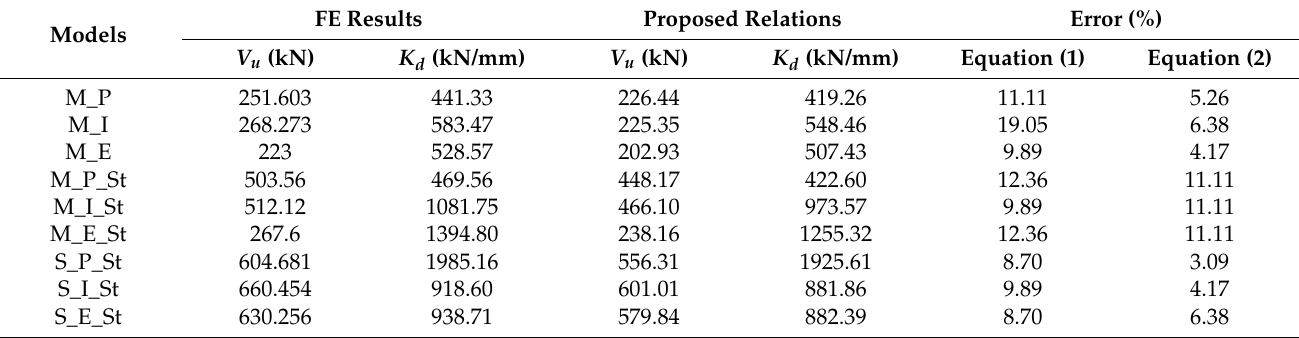
Table 5. Comparing the FE results with the proposed